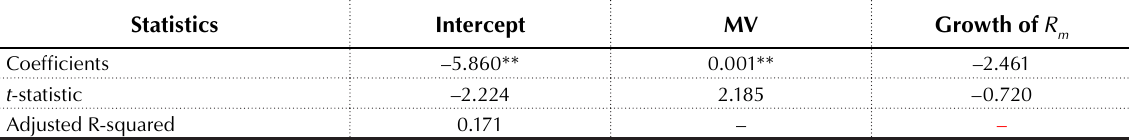
Table 10. The association between three-year growth rate of market adjusted change of MVA with average market value and three-year growth rate of market